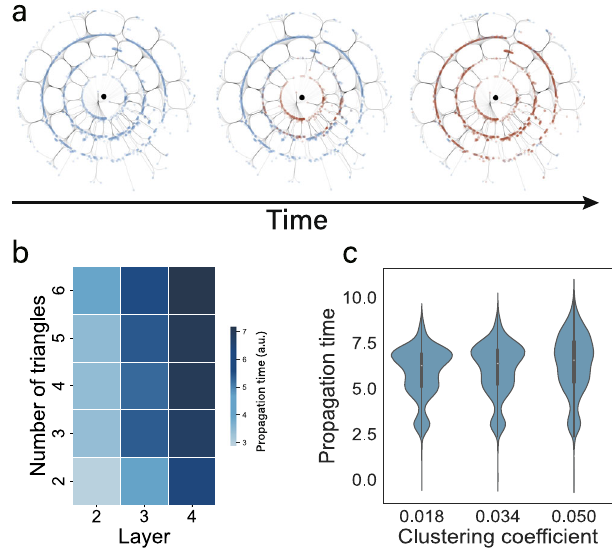
Fig. 4| Impactoftriangleson globalpropagationinprotein-proteinnetworks. a Signal propagation snapshots of protein-protein networks 35 . Central node is the source node inducing a perturbation. Nodes in the same layer (same radial dis- tance) have same shortest path length to the source. Brown nodes indicate the arrivaloftheperturbationin(anarbitrarily) fi xedtime. b Averagepropagationtime as a function of number of triangles and layers in ( a ). For a given layer, triangles slow propagation. Average propagation time increases with both number of tri- angles and layers. c Signal propagation in rewired networks with varying the clus- tering coef fi cient by edge rewiring. For all three networks, high clustering and triangle density slows the spreading of the perturbation across layers. Panels for , with B = α =1, a =0.8, b =0.5, regulatory dynamics, _ x i ð t Þ = (cid:2) Bx ia + α ∑ N j =1 A ij x jb 1+ x jb and N